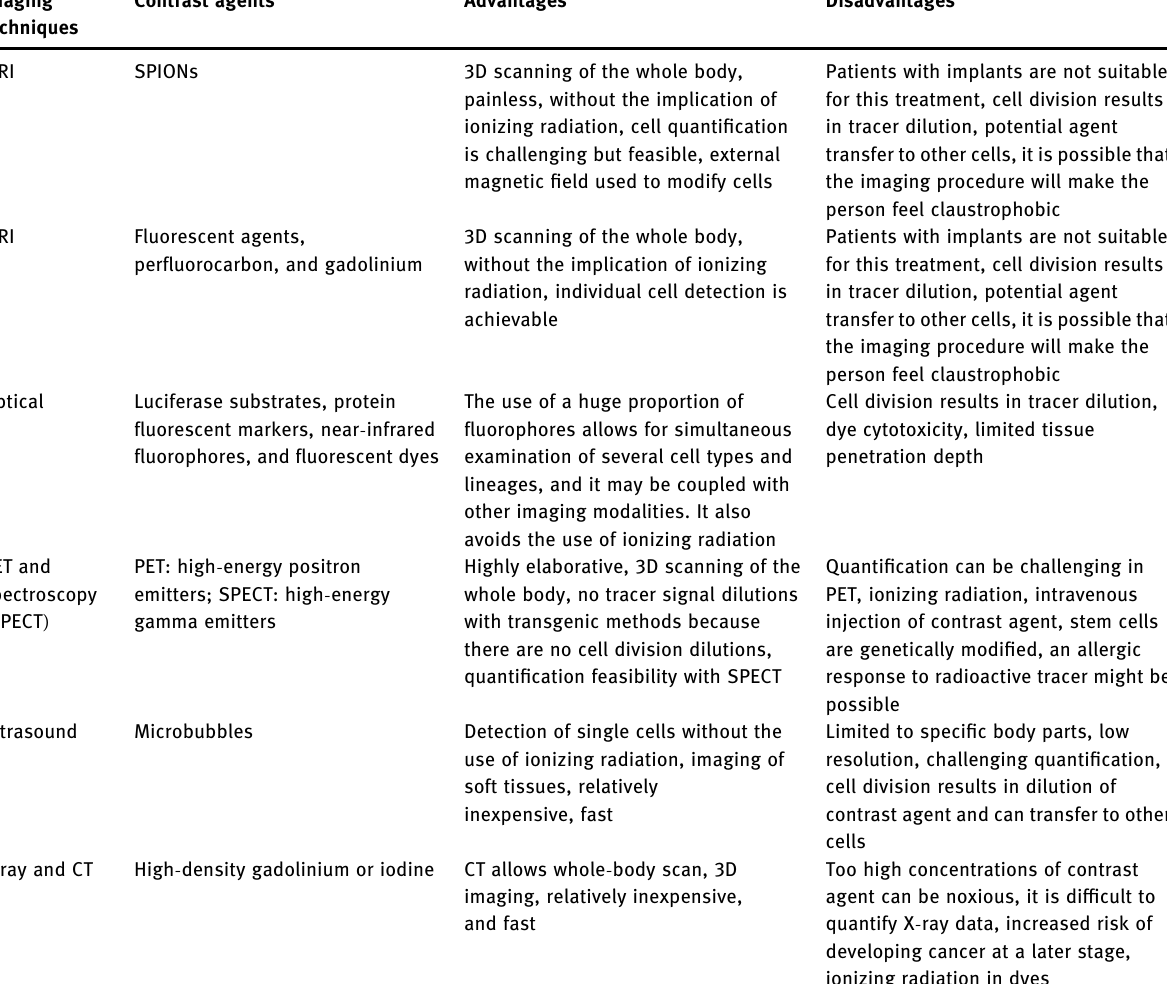
Table 2: Pros and cons of various imaging methods and contrast agents applied for in vivo cellular imaging and tracking. Reprinted with permission from ref. [ 16